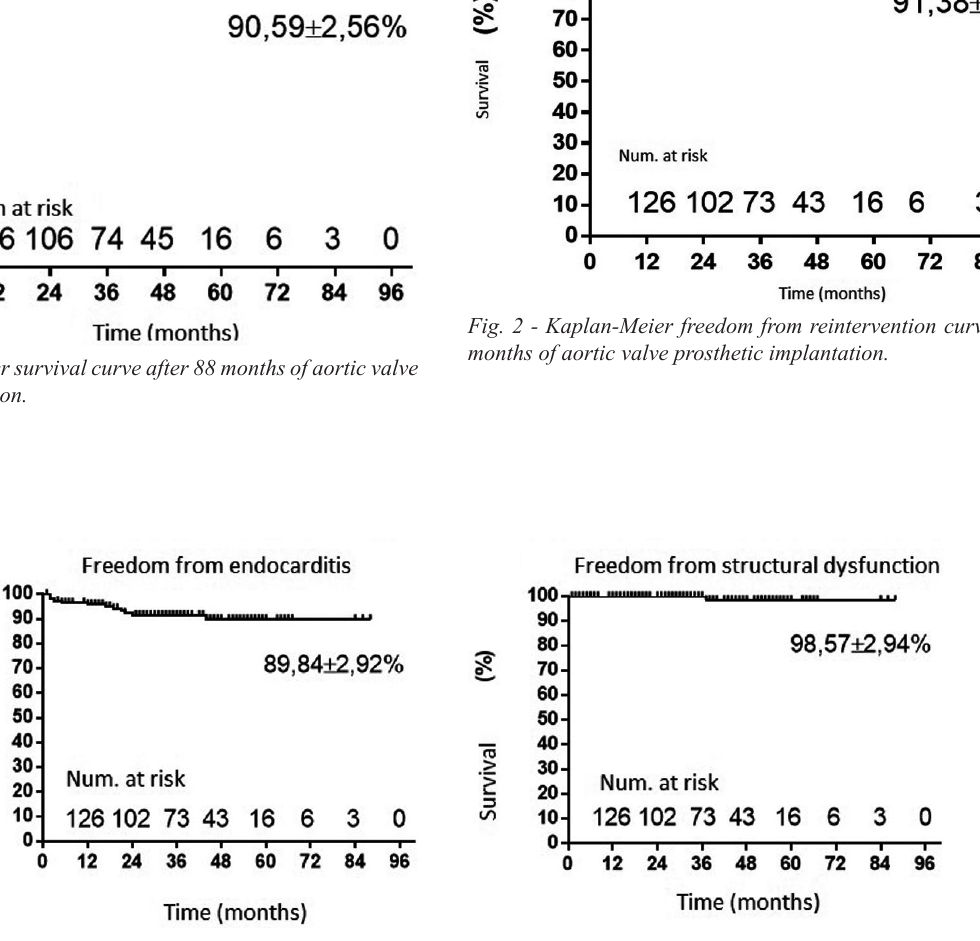
Fig. 3 - Kaplan-Meier curves, freedom from endocarditis and from structural valve dysfunction after 88 months of aortic valve prosthetic